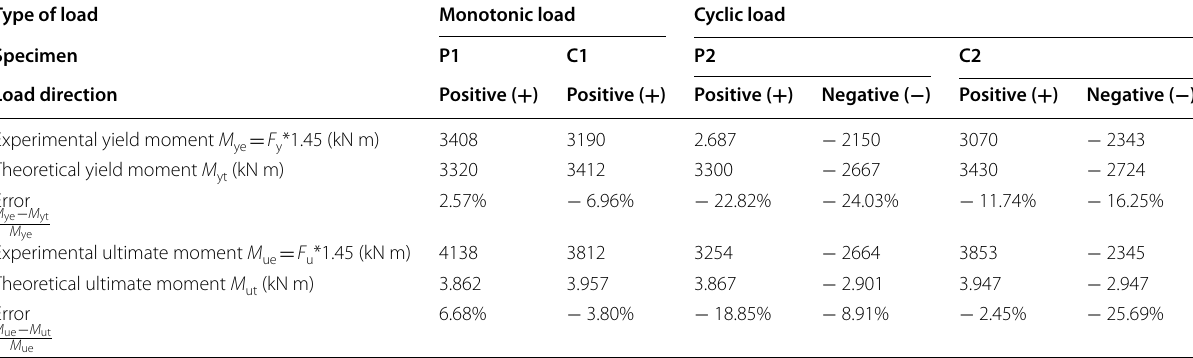
Table 4 Comparison between the results from the experimental test and the theoretical calculation. Type of load Monotonic